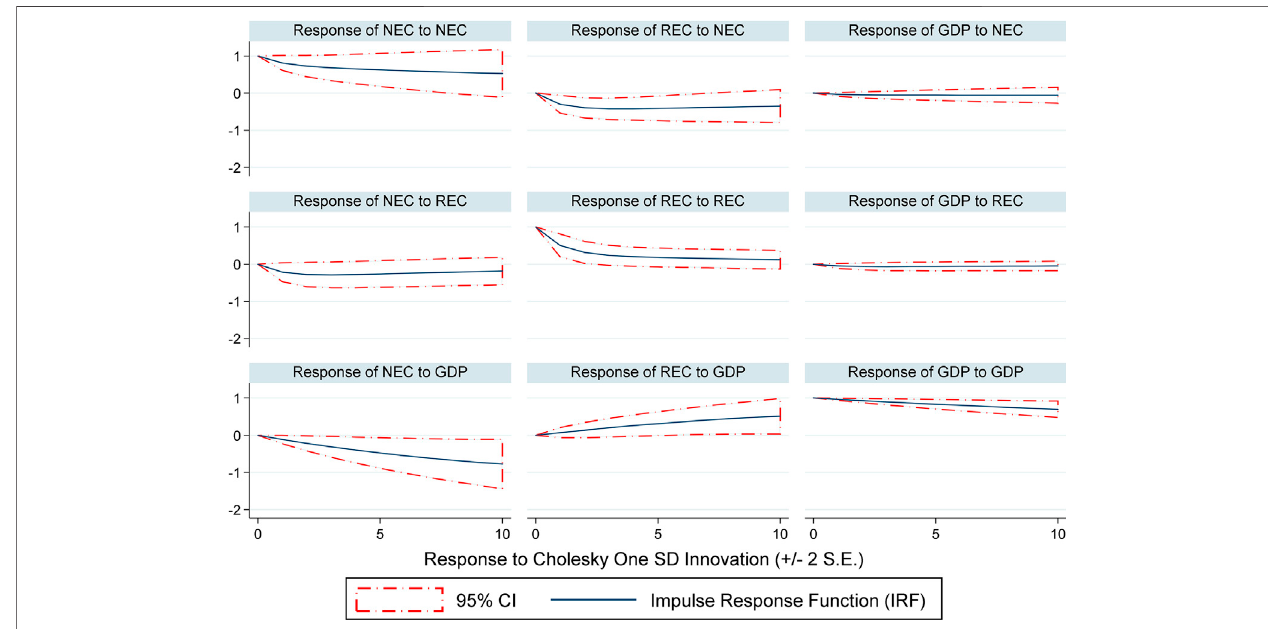
FIGURE 3 | Impulse Response Functions for France. Source: our elaboration.